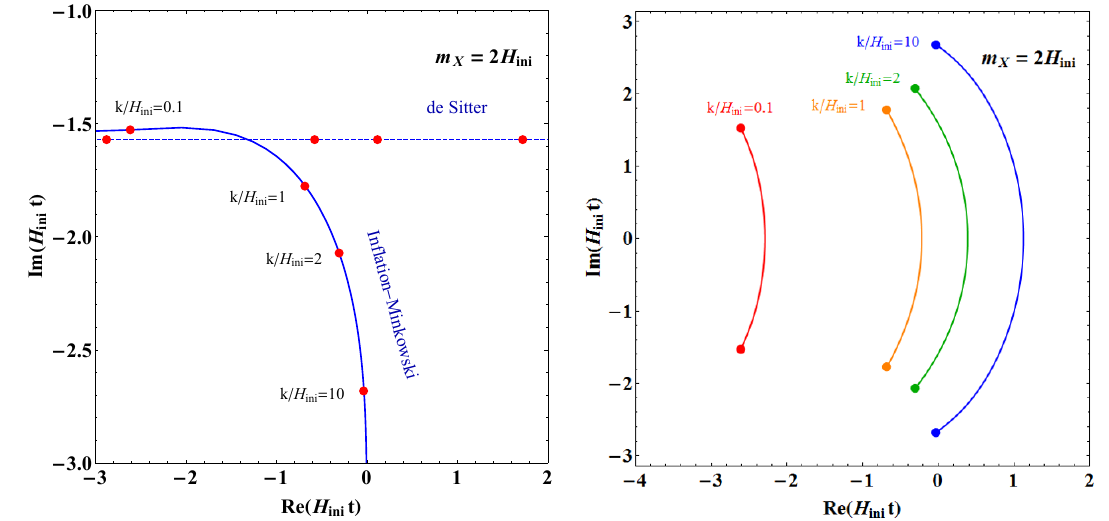
Figure 1 . Left: t c with di(cid:11)erent k . The solid blue curve corresponds to the trajectory of t c ( k ) in our toy model of smooth transition. The dashed blue curve is the corresponding trajectory for de Sitter. Right: the Stokes lines de(cid:12)ned in appendix A with the same conditions as the left panel. Each Stokes line passes though t c and t (cid:3) c